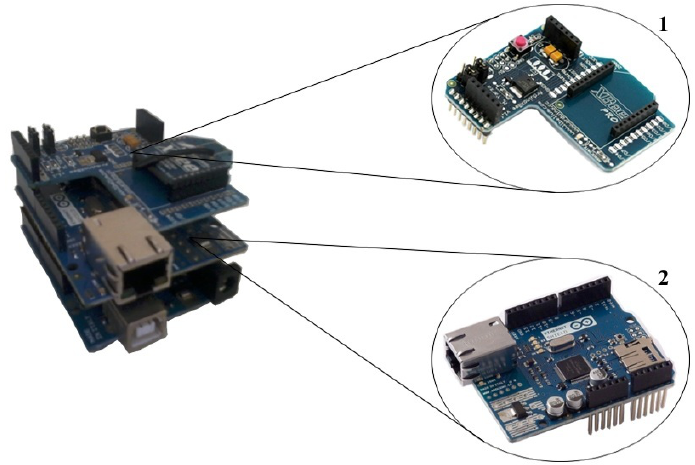
Figure 3. Gateway developed with the Arduino platform using the XBee shield (Label 1) and the Ethernet shield (Label